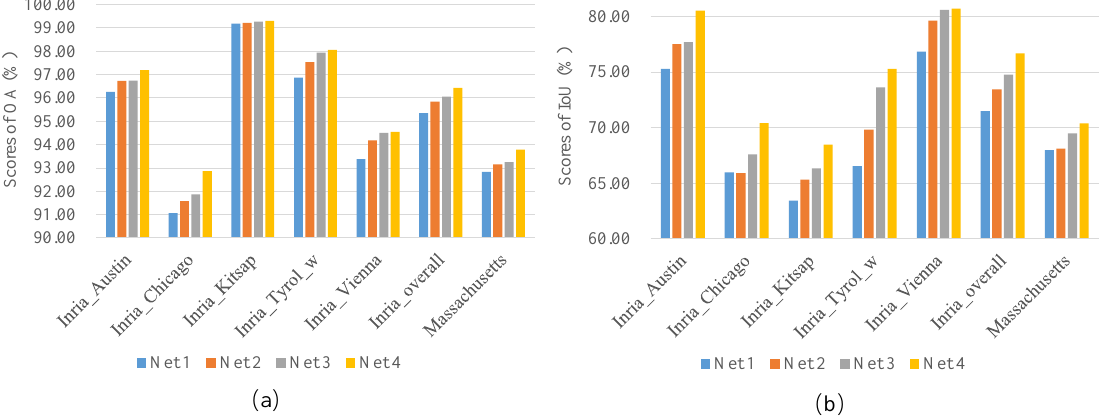
Figure 9. Ablation study of our GMEDN. ( a ) Results in OA, ( b ) Results in